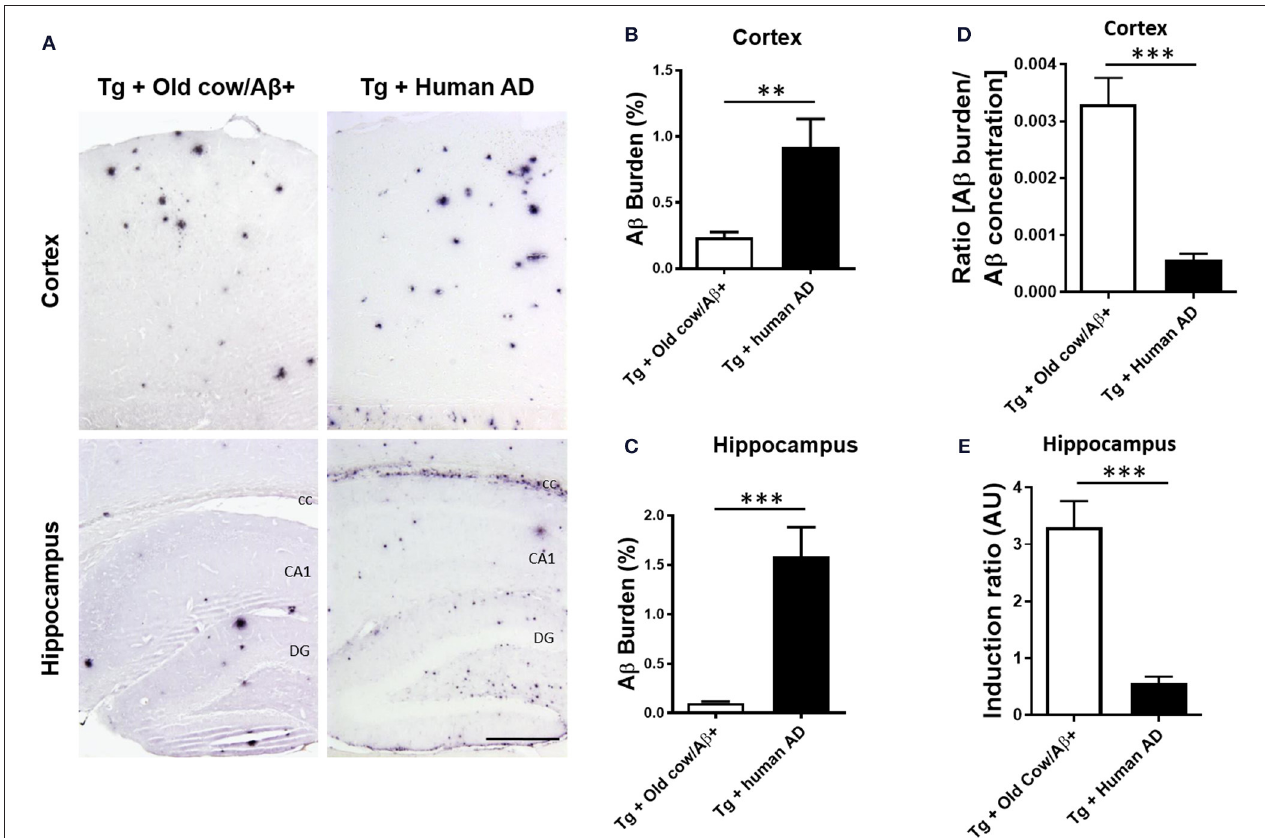
FIGURE 5 | Comparison of amyloid induction by injecting A β − rich old cow and human AD brain extracts. (A) Representative pictures of 4G8 immunostaining in APP/PS1 transgenic mice inoculated with A β − containing old cattle brain extract or AD human brain homogenate. Pictures of the cortex and hippocampus regions are shown. A β burden in the cortex (B) and the hippocampus (C) was quantified by image analysis and expressed as the percentage of the A β immunoreactive area in relation to the total area analyzed. Data represents the average ± standard error of the animals analyzed ( n = 7–9 per group). Since the amount of insoluble A β aggregates in the cow and human inoculum was substantially different, we estimated the induction ratio by dividing the A β burden (%) obtained in transgenic mice by the quantity of insoluble A β injected (pg/mg of brain) x 1,000 (arbitrary units, AU). Induction ratio was determined in the cortex (D) and the hippocampus (E) which was expressed as the average ± standard error of the mean. Data in panels B-E was analyzed by student T-test, ** p < 0.01, *** p < 0.001. cc, corpus collosum; CA1, Cornu Ammonis area 1; DG, dentate